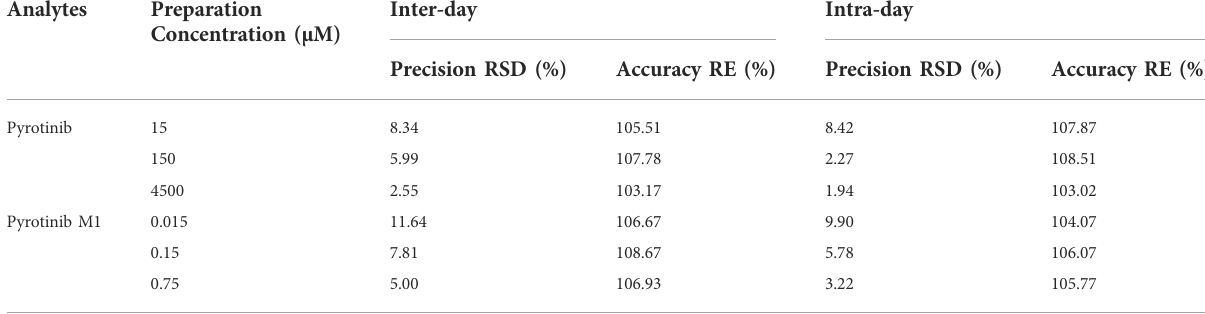
TABLE2Evaluationoftheintra-andinter-day precision bytheproposedUPLC-MS/MSmethodfordeterminationofpyrotinibandpyrotinib M1inrat plasma ( n = 6).